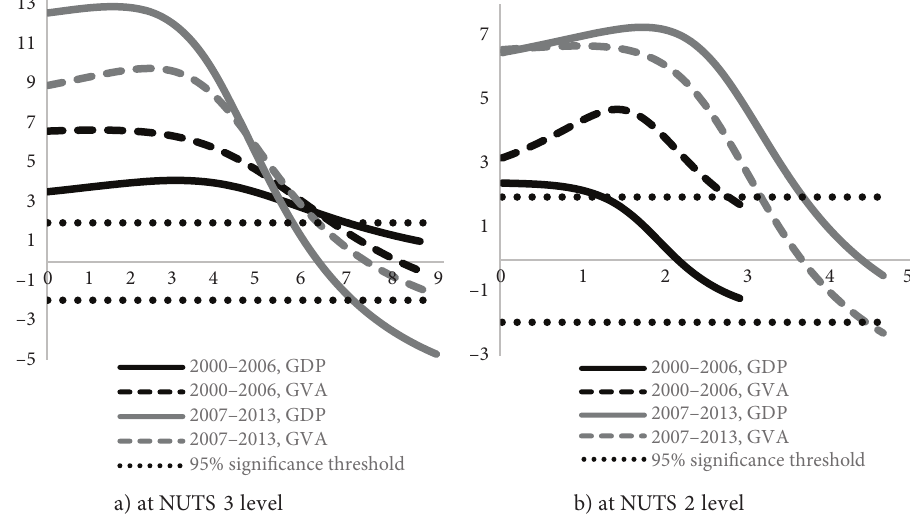
Figure 4. Relationship between CP transfers’ intensity ( i ICP , horizontal axis) and t-ratio (vertical axis) of estimated conditional effect